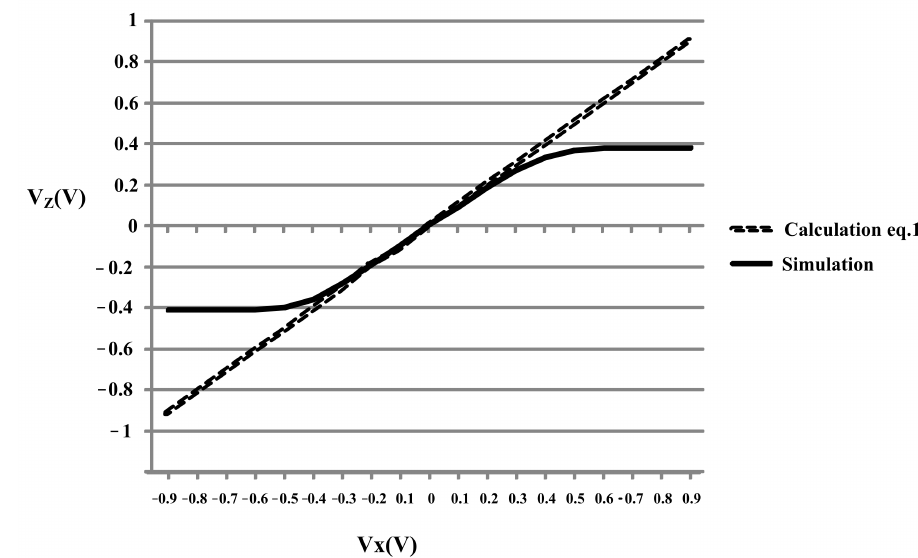
Figure 11. DC transfer characteristic between V Z and V X .